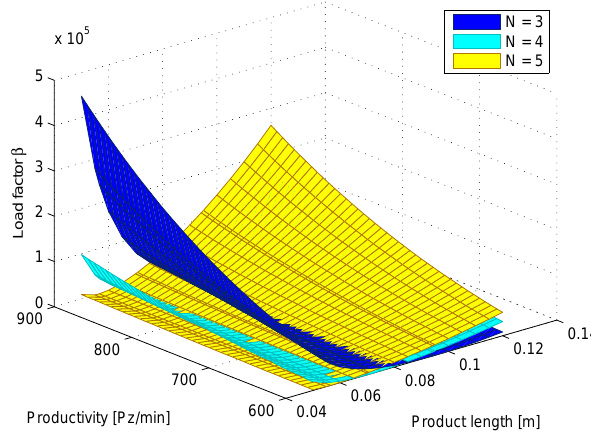
Figure 10. β surface as a function of tools number.